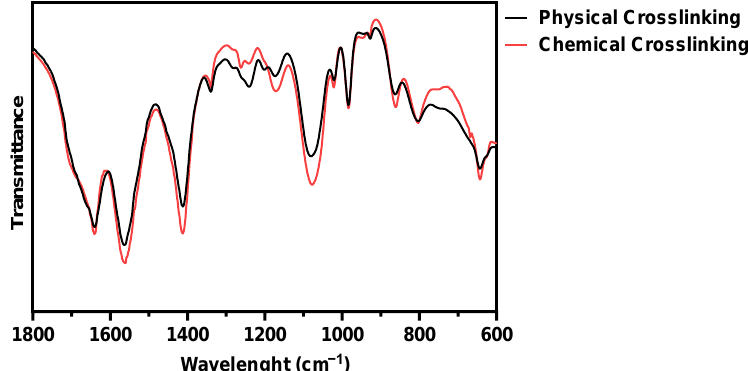
Figure 2. FT-IR spectra of physically and BL-activated RFP-induced chemically crosslinked collagen hydrogels.